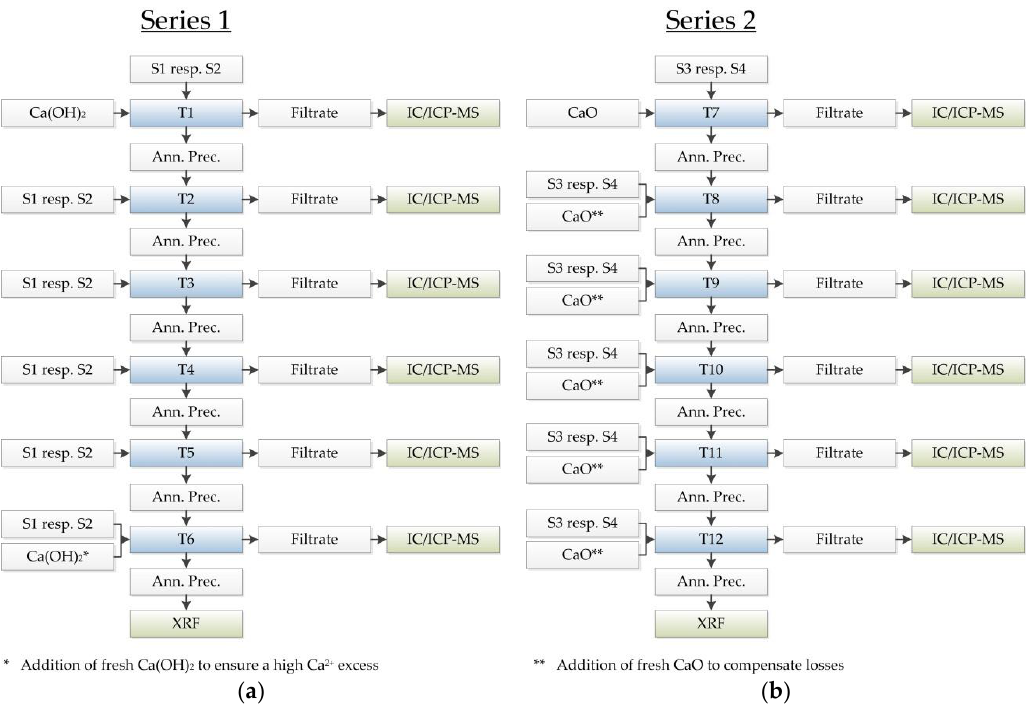
Figure 4. Test procedure of series 1 ( a ) and series 2 ( b ) Ann. Prec., annealed precipitate; IC, ion chromatography; ICP-MS, inductively coupled plasma mass spectrometry; and XRF, X-ray fluorescence.